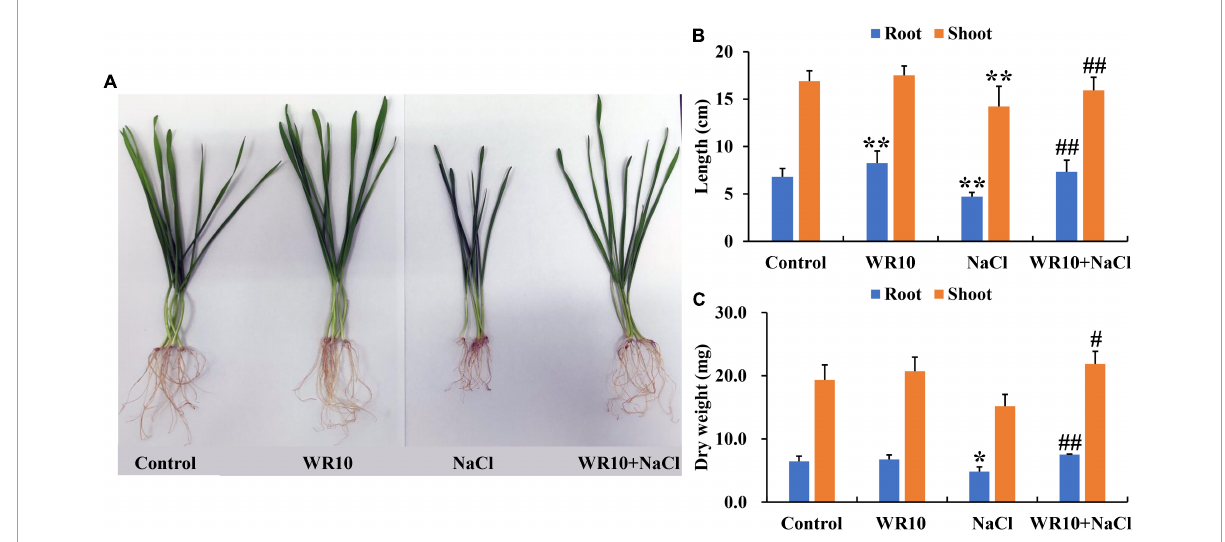
FIGURE1 Bacillus altitudinis WR10 alleviates the adverse effects of salt stress on wheat seedlings. (A) Photograph of wheat seedlings; (B) lengths of roots and shoots; (C) dry weights of roots and shoots. Control, without NaCl and WR10; WR10, with WR10 and without NaCl; NaCl, with NaCl and without WR10; WR10 + NaCl, with NaCl and WR10. Data are expressed as the means ± SD ( n = 12). * p < 0.05, ** p < 0.01 (vs. control); # p < 0.05, ## p < 0.01 (vs.